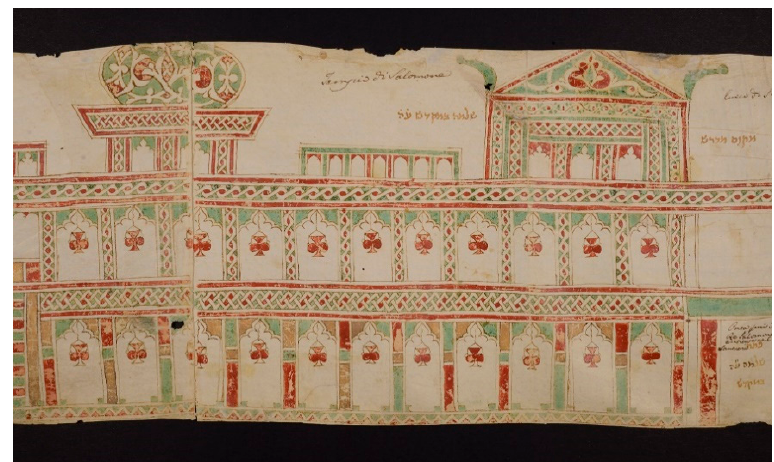
Figure 5. Florence, BNC, Ms. Magl. III, 43; The Cave of the Makhpela in Hebron, early 14th century, by courtesy of Ministero dei beni e delle attività culturali e del turismo/Biblioteca Nazionale Centrale di Firenze.